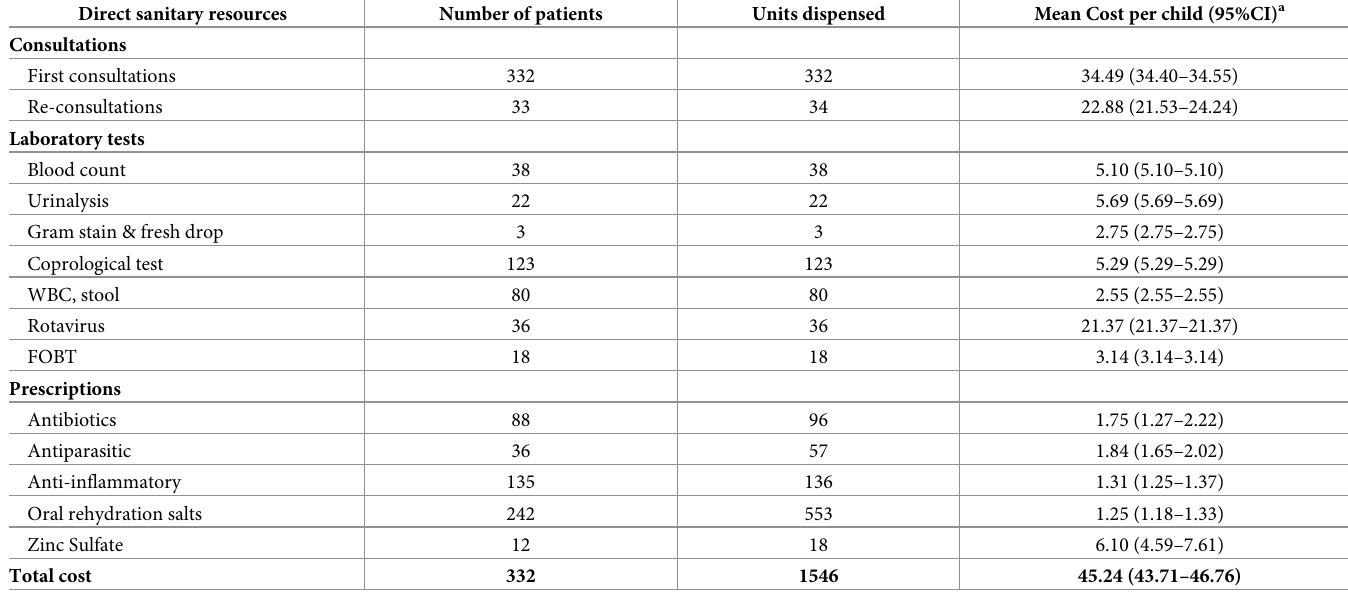
Table 3. Resources used and mean cost per